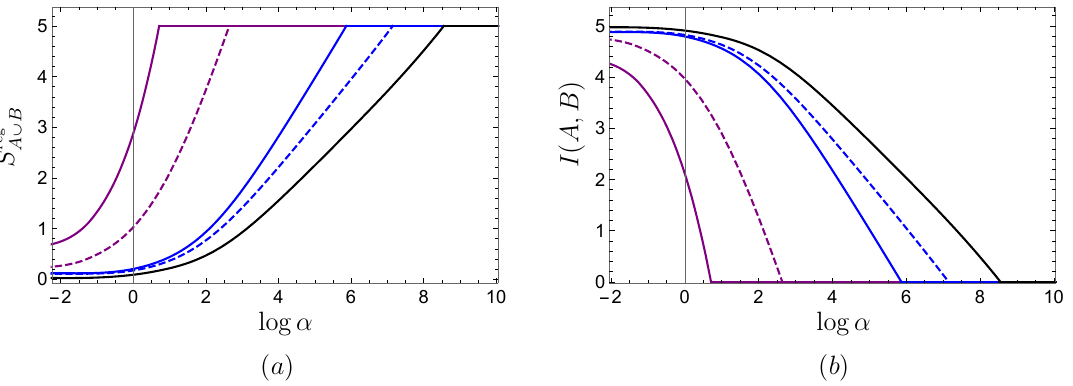
Figure 7 . (a) Shock wave parameter (cid:11) as a function of the turning point r 0 normalized by r some values of =T 2 . The continuous (dashed) curves represent the results for orthogonal (parallel) B strips. The black curve represents the result at the UV (cid:12)xed point ( =T 2 = 0), while the red curves B represent the results at the IR (cid:12)xed point ( =T 2 1). The blue curves represent the results for B (cid:29) =T 2 = 12 : 3, while the purple curves represent the results for =T 2 = 133. (b) Critical point B B r 0 = r c (at which (cid:11) ( r 0 ) diverges) versus =T 2 . The continuous (dashed) blue curve represents the B result for an orthogonal (parallel) strip. The dashed horizontal line in the middle indicates the result at the UV (cid:12)xed point, r c =r = (3 3 = 4 1) = 2, while the top and bottom ones show the results H (cid:0) at the IR (cid:12)xed point, r jj c =r = 1 = p 2 and r ? =r = 0, respectively. c H H